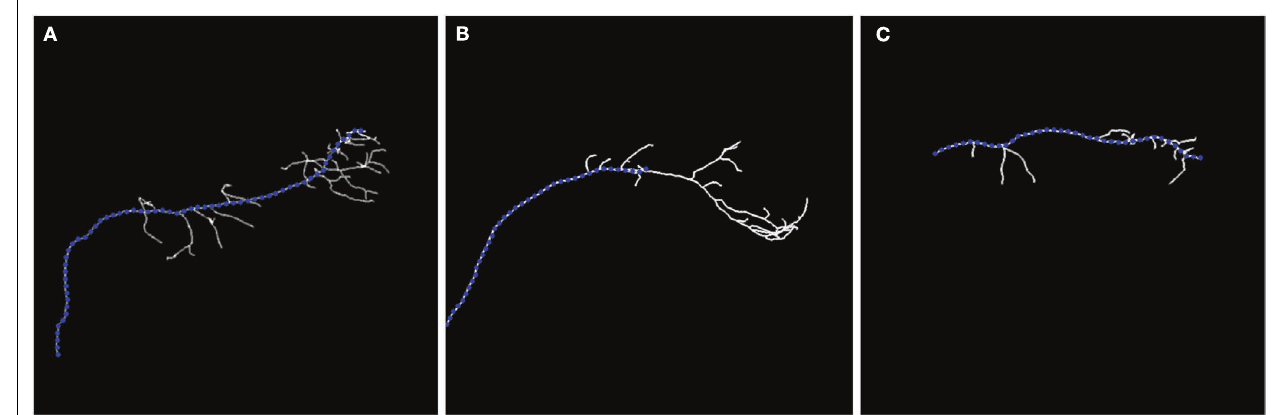
FIGURE 4 | Maximum intensity projection image (MIP) of: olfactory projection fibers (A) OP1; (B) OP2; (C) OP3 with superimposed reconstruction. No multi-scaling was applied to obtain reconstructions.